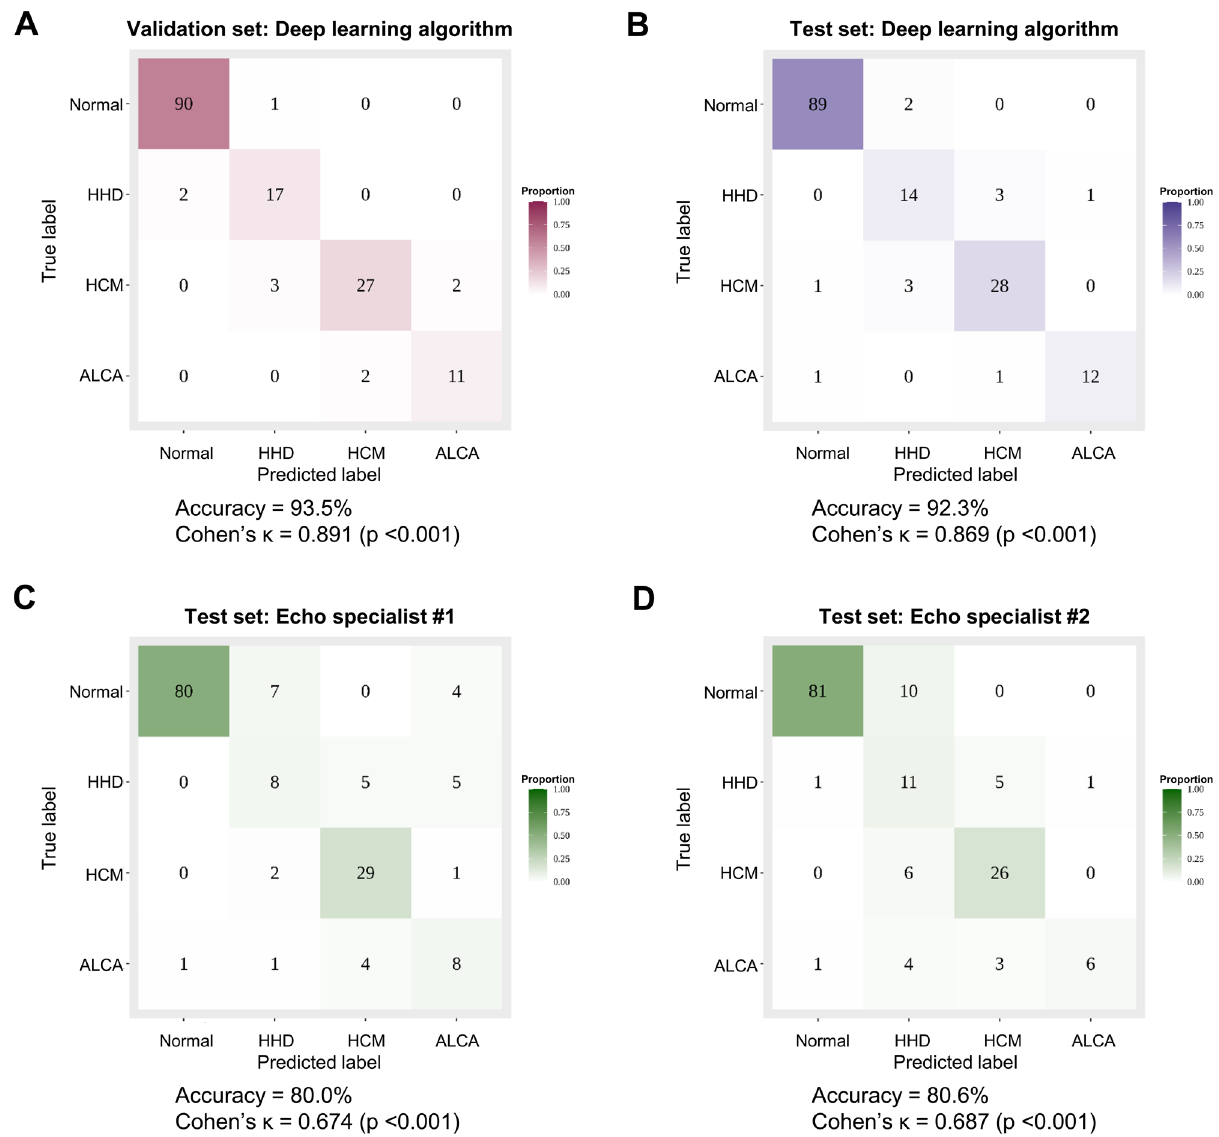
Figure 4. Diagnostic accuracy of the deep learning algorithm compared to that of expert cardiologists. The diagnostic accuracy of the deep learning algorithm was assessed using the confusion matrix for the validation ( A ), and test sets ( B ). The accuracy was also compared to that of two echocardiography specialists using the test set ( C , D ). This figure was generated using R software v.4.1.1, R Core Team (2021). R: A language and environment for statistical computing. R Foundation for Statistical Computing, Vienna, Austria. URL http:// www.r- proje ct. org/. AUC area under the ROC curve, CI confidence interval, ALCA light-chain cardiac amyloidosis, HCM hypertrophic cardiomyopathy, HHD hypertensive heart disease, ROC receiver operating characteristic